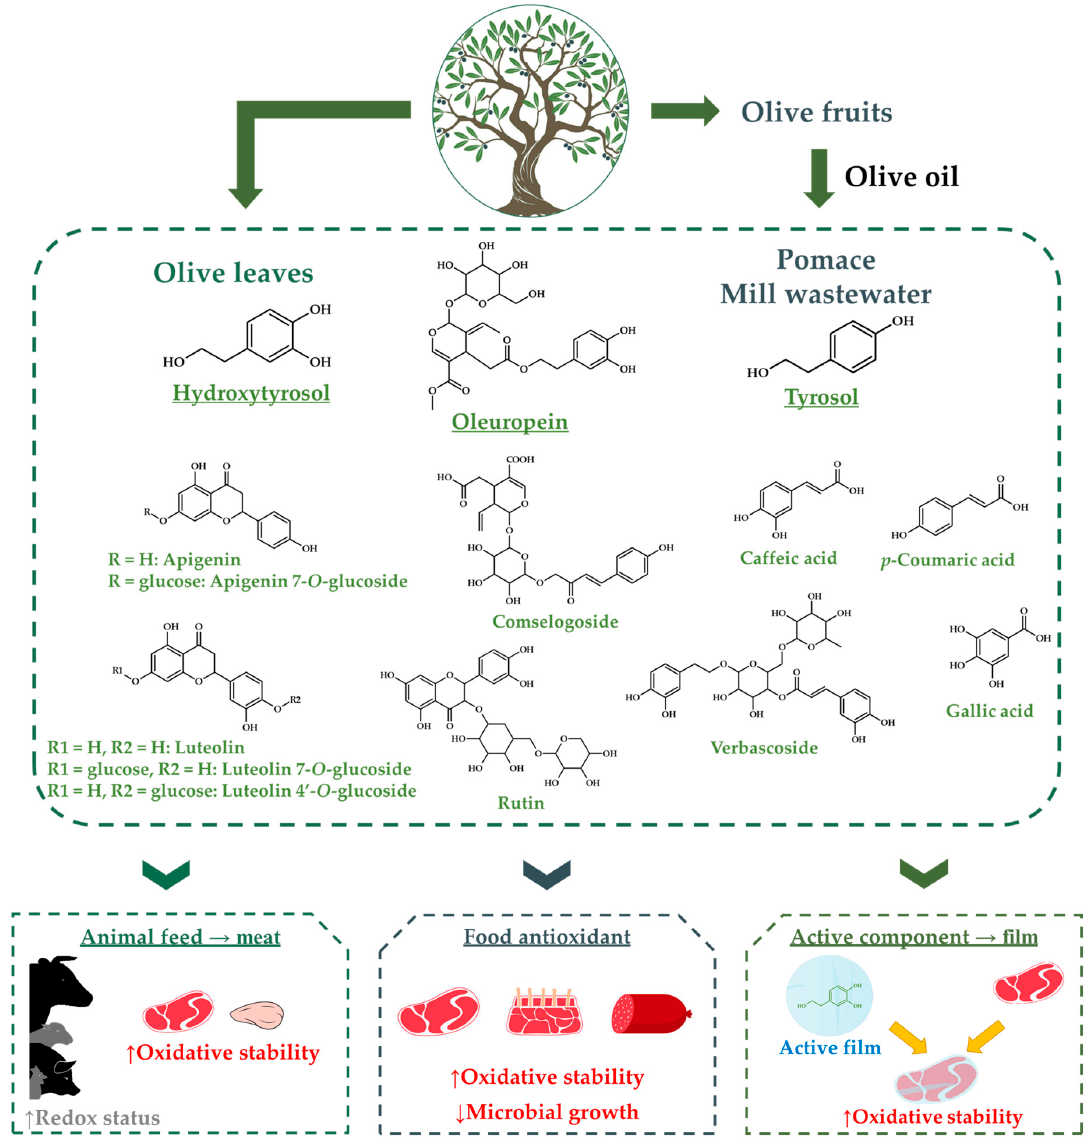
Figure 1. Schematic representation of the strategies to use polyphenol-rich extracts from Olea europaea to improve the quality and preservation of meat and meat products.